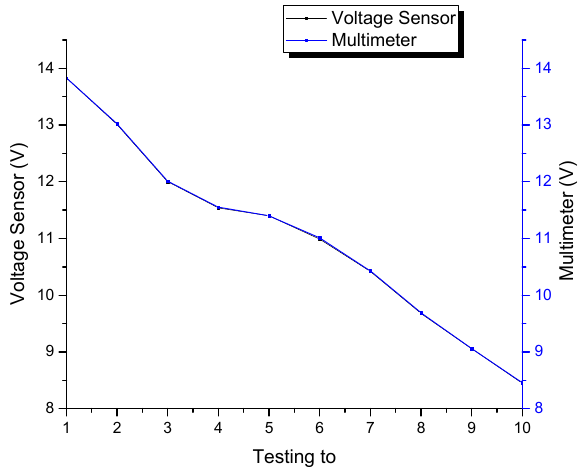
Figure 8. Test results of the voltage sensor.